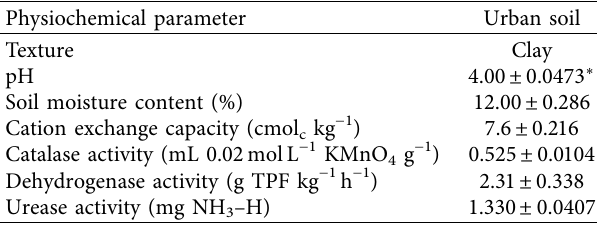
Table 1: The selected urban soil